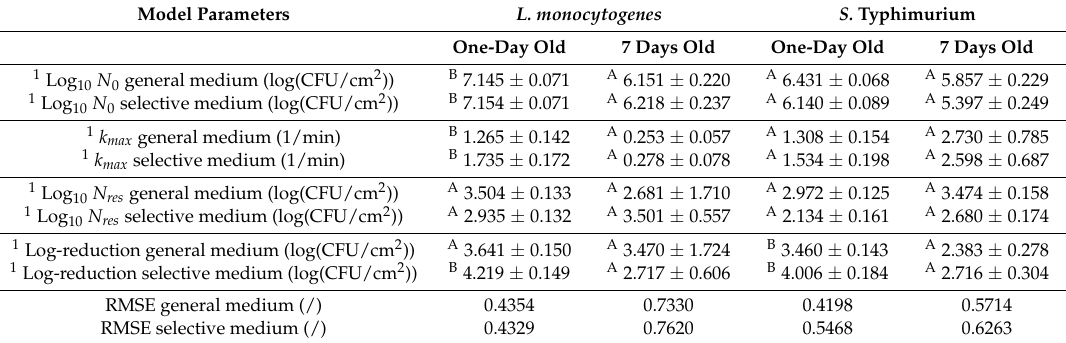
1 Influence biofilm age: for each microorganism and each growth medium, model parameters bearing different superscripts (no letters in common) are significantly different ( p ≤ 0.05). Parameters bearing the lowest values have been indicated with ‘A’, while those bearing the highest values have been indicated with